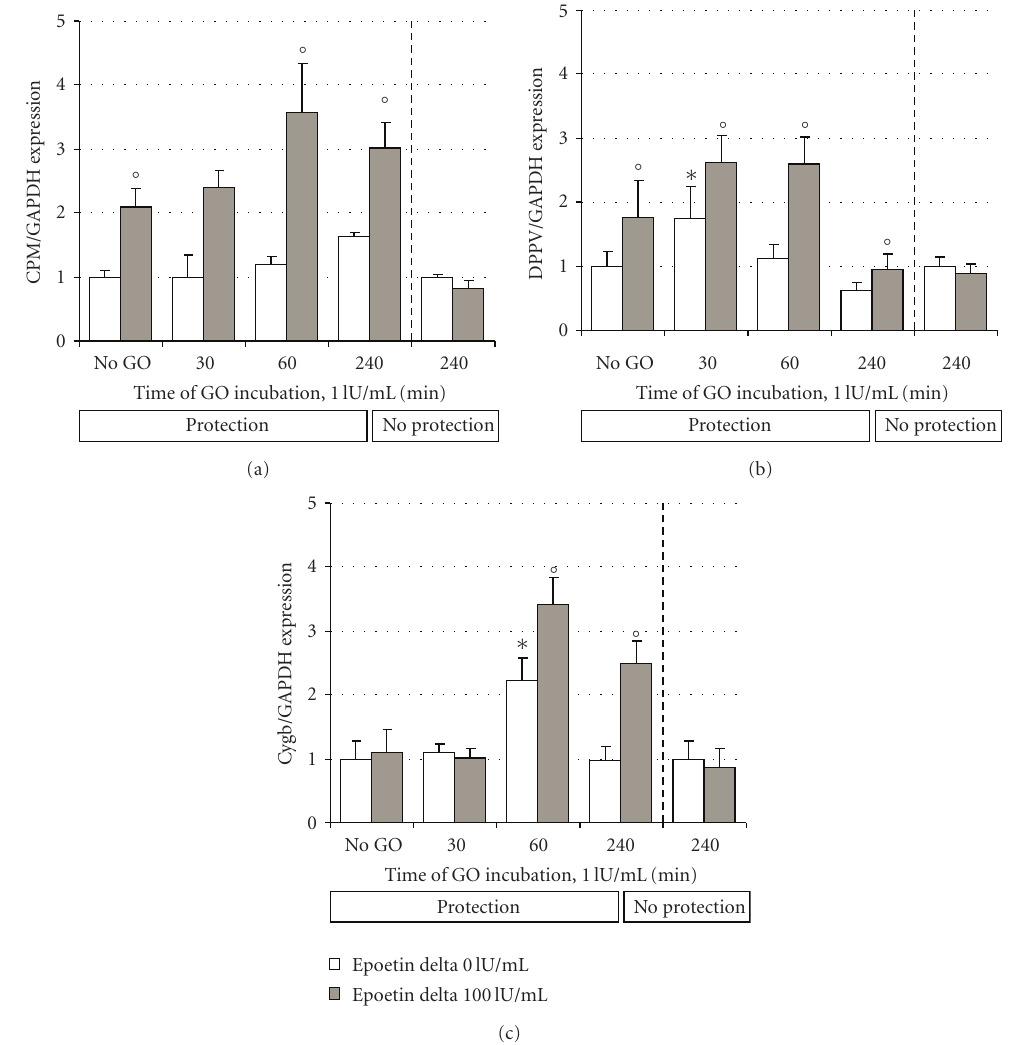
Figure 6: Comparison of the relative (normalized to GAPDH and to calibrator sample) expressions of CPM (a), DPPIV (b), and Cygb (c) under basal conditions and after GO-induced oxidative stress (1IU/mL) in cell cultures originating from two di ff erent kidney specimens, one showing EPO-induced anti-oxidative e ff ects and one without any e ff ect of EPO on oxidative stress. Preconditioning the cells with EPO resulted in a significant upregulation of CPM and DPPIV, mRNA. GO-induced oxidative stress further increased CPM, DPPIV and Cygb mRNA expressions with maximum levels 60 minutes after induction of oxidative stress. Remarkably, the cell culture in which epoetin delta was not able to induce a protective e ff ect against oxidative stress was also not able to induce upregulation of those mRNA’s. Data are presented as the mean ± SD of triplicate determinations representative of 2 separate runs (i.e., 6 values each). ∗ P < . 05 versus no GO, ◦ P < . 05 versus epoetin delta 0